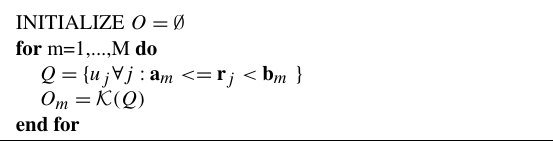
Figure 6. This schematic shows the collocation of gridded data onto an ungridded sampling where the altitude component of the data is defined on a hybrid height grid. CIS will first collocate the data in the coordinate dimensions (latitude, longitude, etc.) to extract a single-altitude column and then perform a second interpolation on the altitude coordinate. Algorithm 4 The ‘bin’ collocation of an ungridded dataset onto a gridded sample set of M multi-dimensional cells, as defined by the input file. Upper and lower bounds for each of the cells of the dataset ( b and a respectively) are automati- cally deduced if not present in the data.